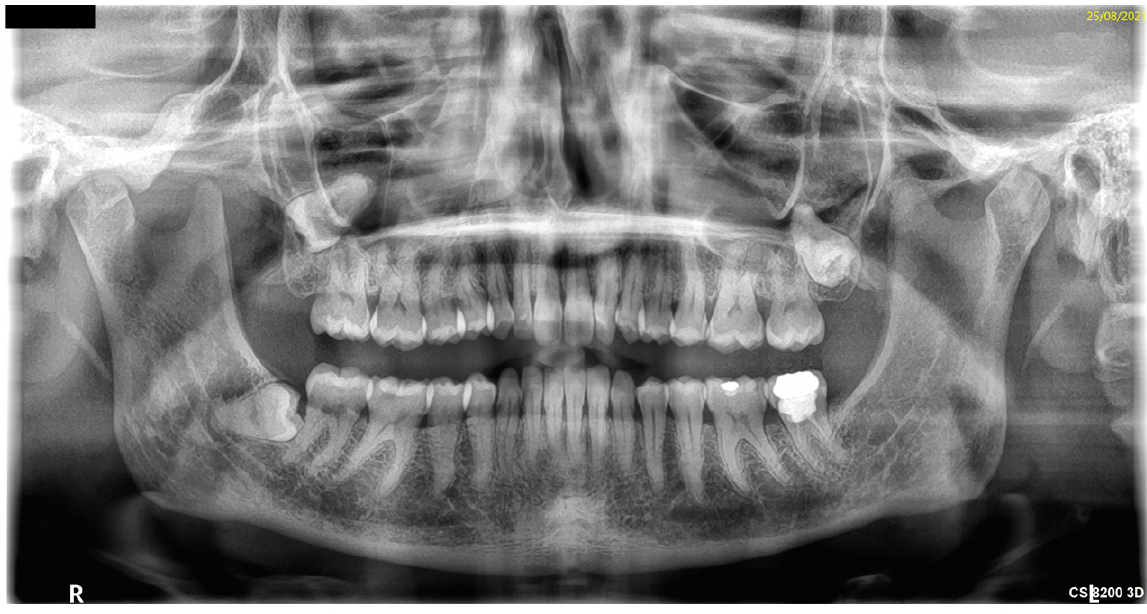
Figure 1. Impacted symptomatic 18 on